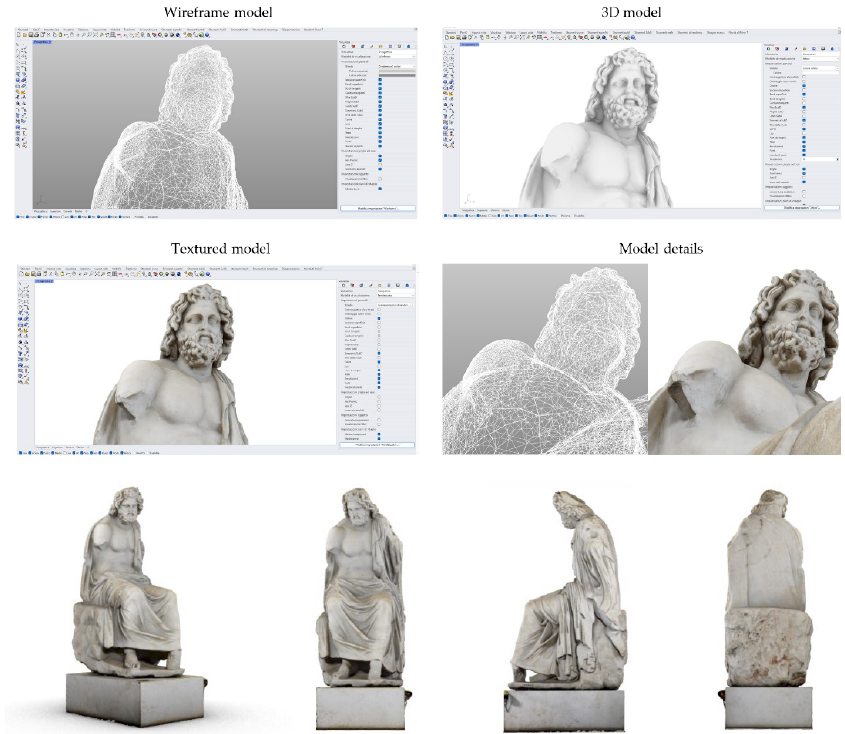
Figure 7. The model and 3D visualisation of Zeus’ sculpture: from the mesh model to the textured NURBS model. NURBS